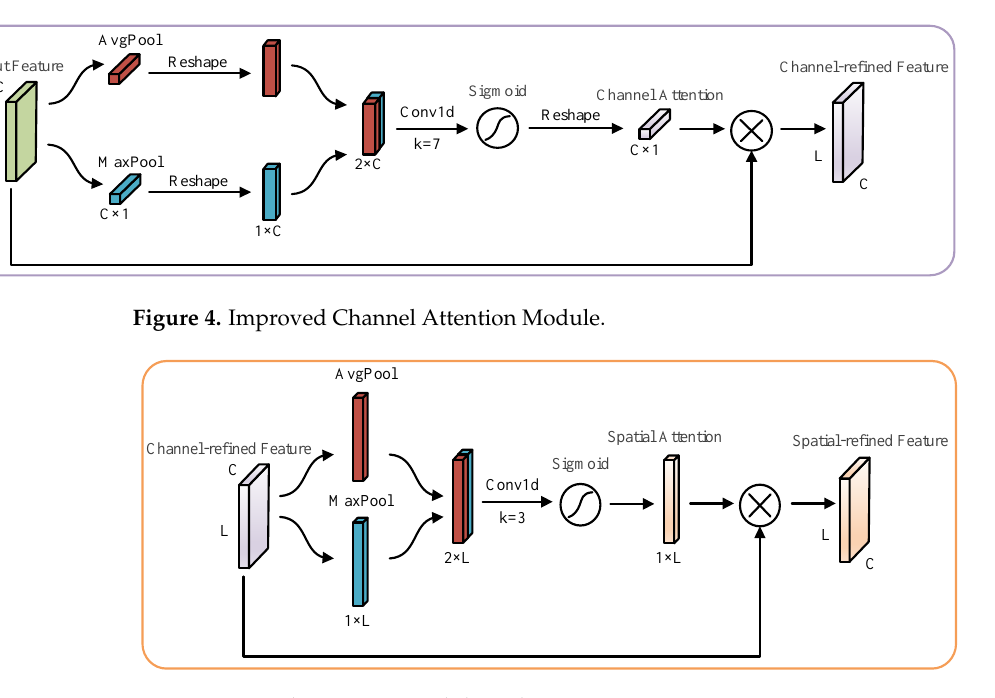
Figure 5. Spatial Attention Module in the CSAM. The channel attention module in the CSAM was processed as follows: First, the input feature map F in is fed into the channel attention module. Then the average pooling and maximum pooling are used to aggregate the spatial information of F in , and two different vectors F c , F c describing the spatial information are obtained. The vectors deformations are stitched together to obtain the spatial information synthesis description vector. After the one-dimensional convolution process, the weights are then compressed to 0~1 by the Sigmoid activation function. The channel attention weights M c are obtained after deformation reduction. The channel attention weight M c is multiplied with the input feature map F in to obtain the channel attention corrected feature map F c